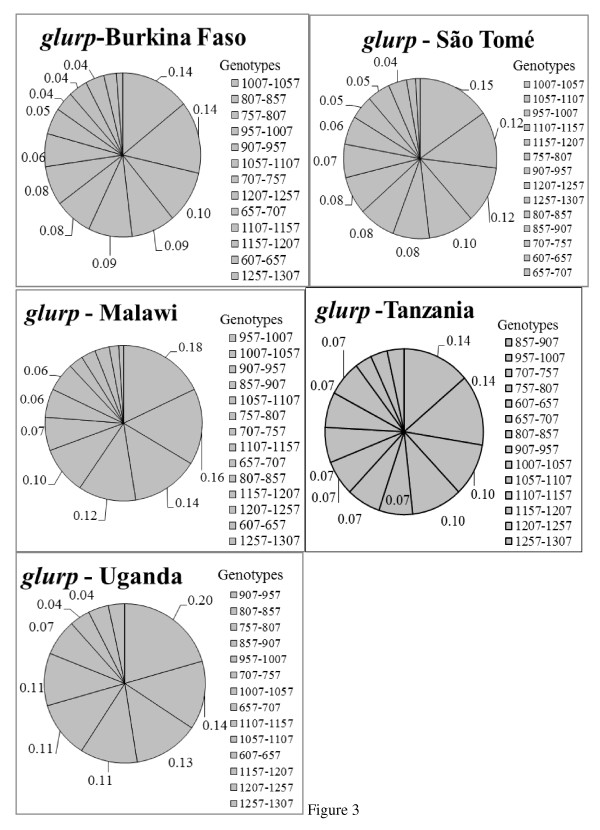
glurp allelic diversity and frequency (%) by country. Only genotypes with frequency ≥ 4% (0.04) are labeled.